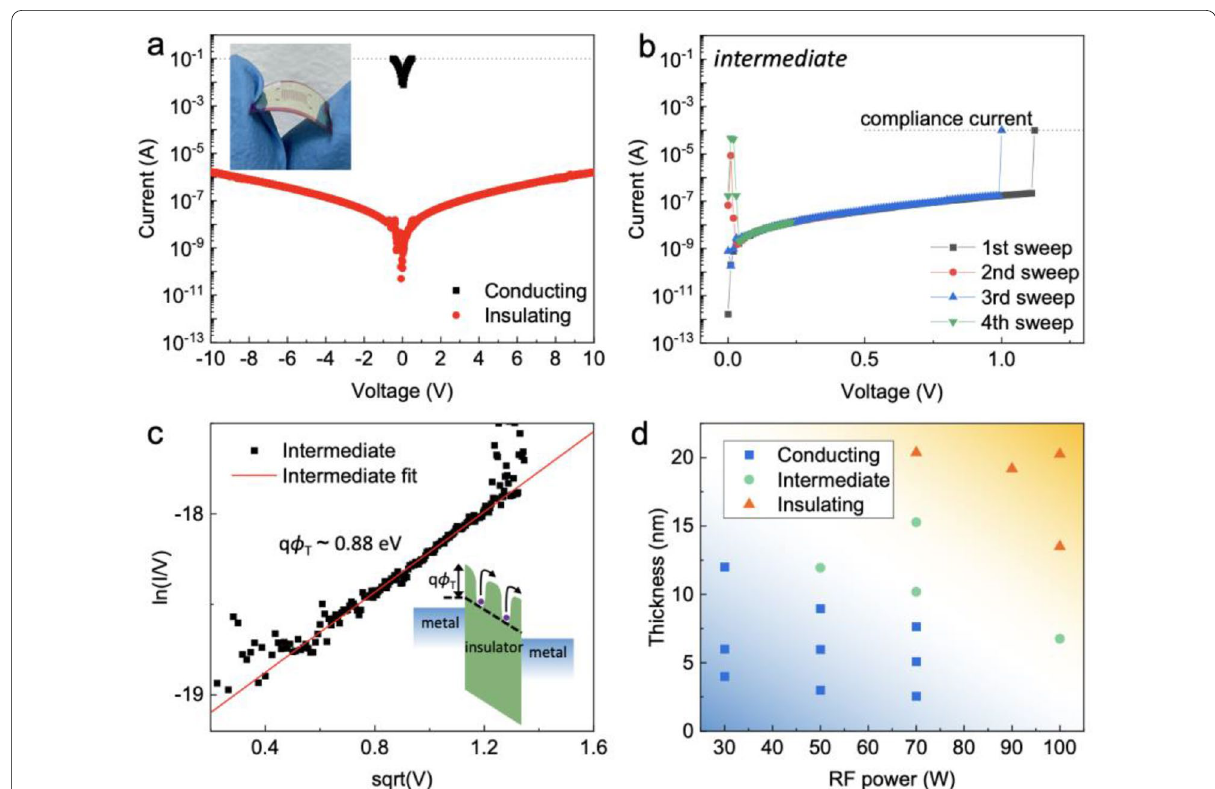
Fig. 1 Electrical behavior of HfO 2- x thin films in various electrical phases. a I-V characteristics of the conducting (black) and insulating (red) states. The inset shows a photograph of a flexible device. b Typical unipolar resistive switching behavior in the intermediate states. c Poole–Frenkel fitting result for the HRS for the intermediate states. The inset shows a schematic of carrier hopping in the Poole–Frenkel conduction. d Phase diagram showing various phases as functions of thickness and rf